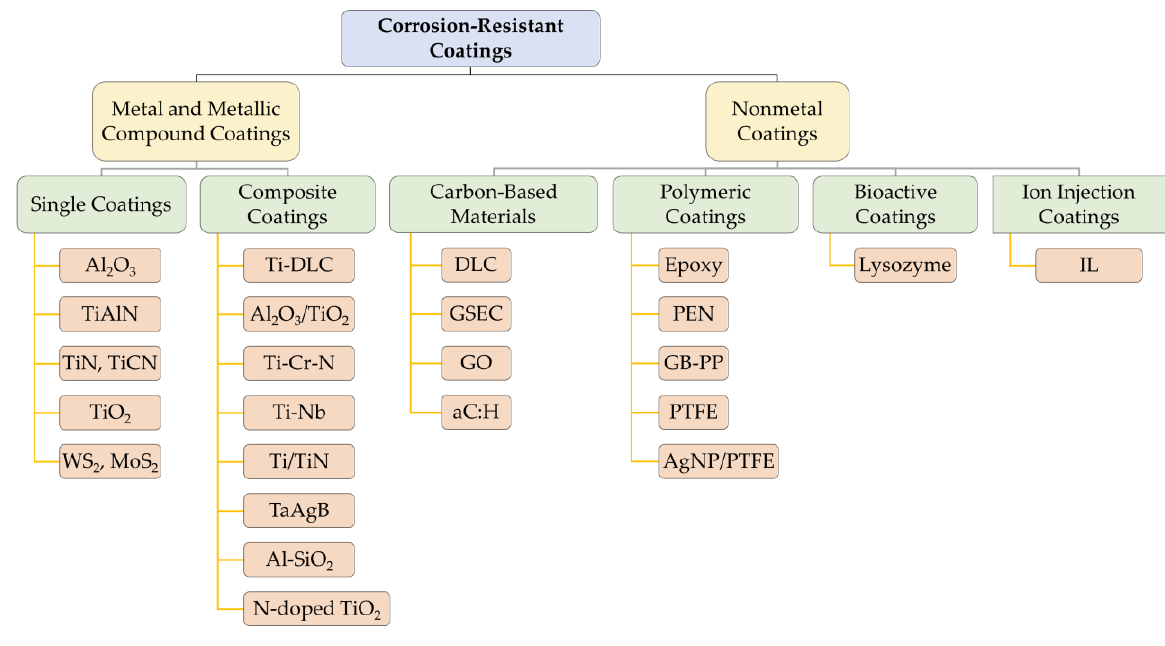
Figure 7. Summary of antibacterial coating materials. TiAlN: titanium aluminum nitride; Ti-DLC: titanium-diamond-like carbon; Al 2 O 3 /TiO 2 : aluminum oxide/titanium dioxide; Ti-Cr-N: titanium- chromium-nitrogen; Ti-Nb: titanium-niobium; Ti/TiN: titanium/titanium nitride; N: nitrogen; aC:H: hydrogenated forms of diamond-like carbon; PEN: polyethylene naphthalate; GB-PP: grid-blasted plasma-polymerized; IL: ionic liquid.